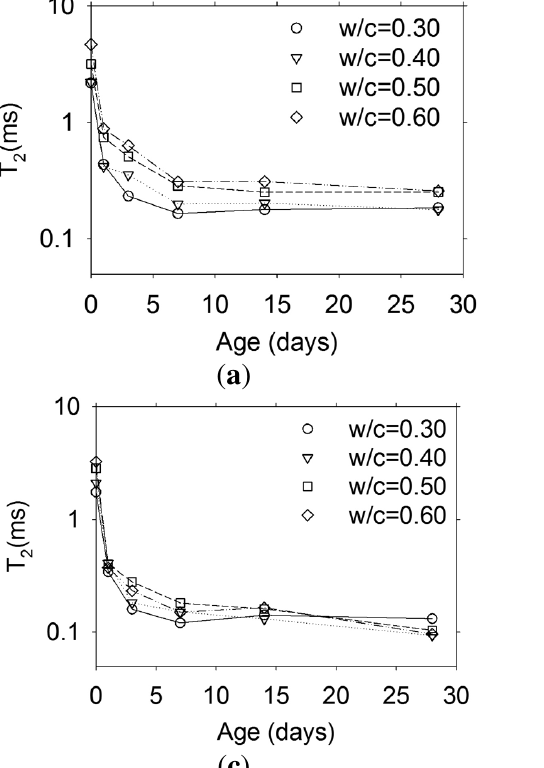
Figure 8. Evolution of the short and long lifetime components ( b ) white cement-long T